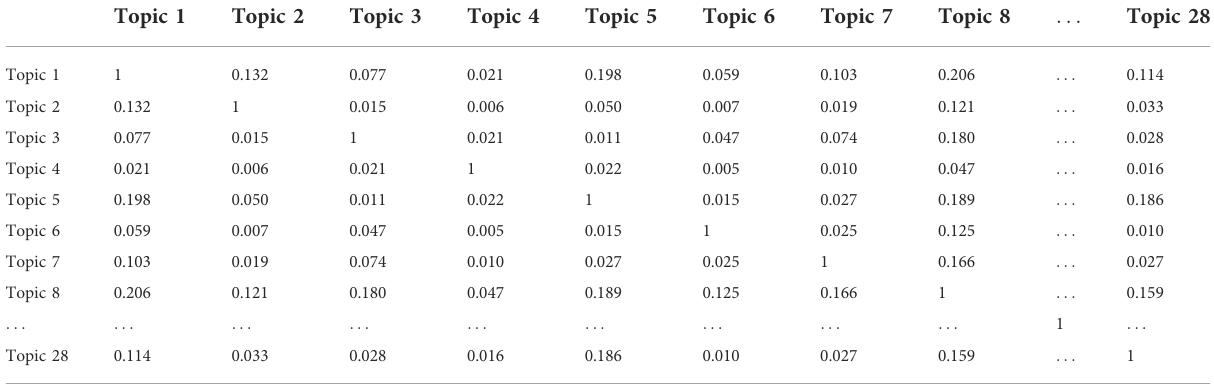
TABLE 5 The semantic similarity results of topics.